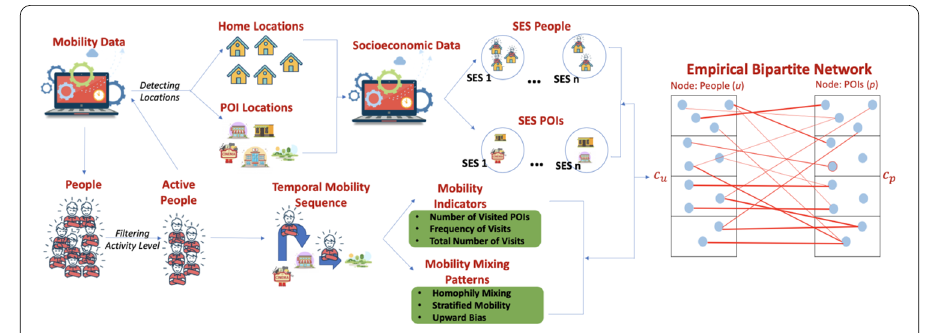
Figure 1 Mobility and socioeconomic data combination pipeline. ( left ) Overview of data sources, data processing pipelines and data combination steps to obtain data for the analysis of socioeconomic segregation in spatiotemporal urban mobility. ( right ) As a result we obtain a bipartite network, with nodes classified into two sets comprising individuals u and POIs p . Each node in both types is labelled by a socioeconomic indicator ( c U and c P ) assigned via our location-based method on the census tract level. Weighted edges between individuals and POIs indicate the frequency of visits of a given user to a given